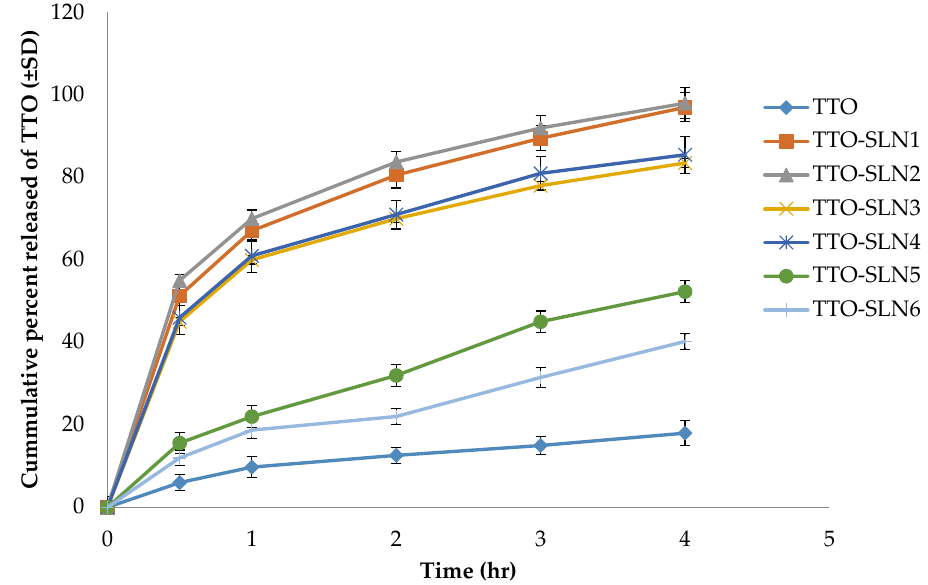
Figure 2. In vitro release study of the plain oil compared to the formulated SLNs.